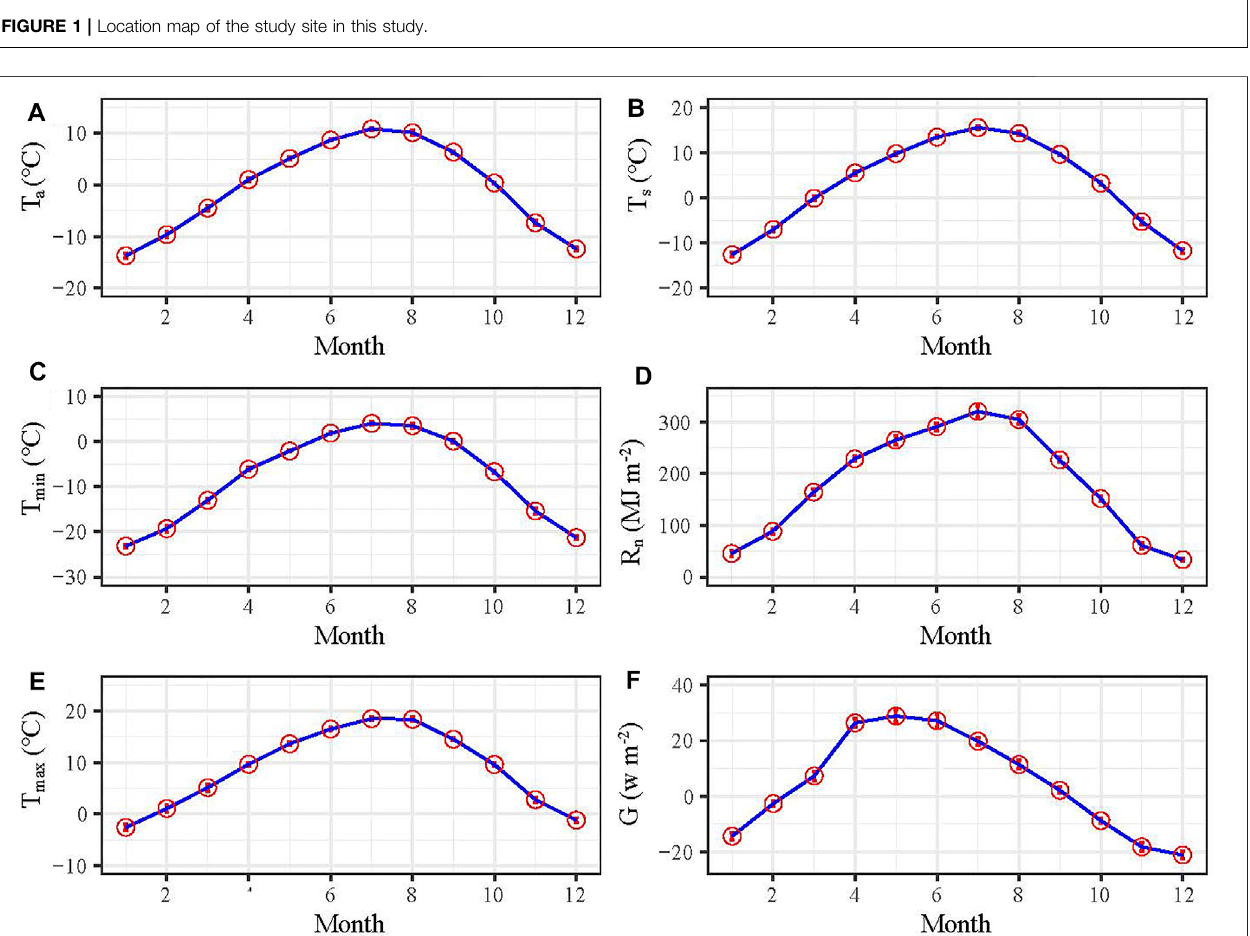
FIGURE2| Seasonalvariation ofenvironmental factors, (A) averageairtemperature (Ta), (B) averagesoil temperature (Ts), (C) minimumairtemperature(T min ), (D) net radiance (R n ), (E) maximum air temperature (T max ) and (F) soil heat fl ux (G).